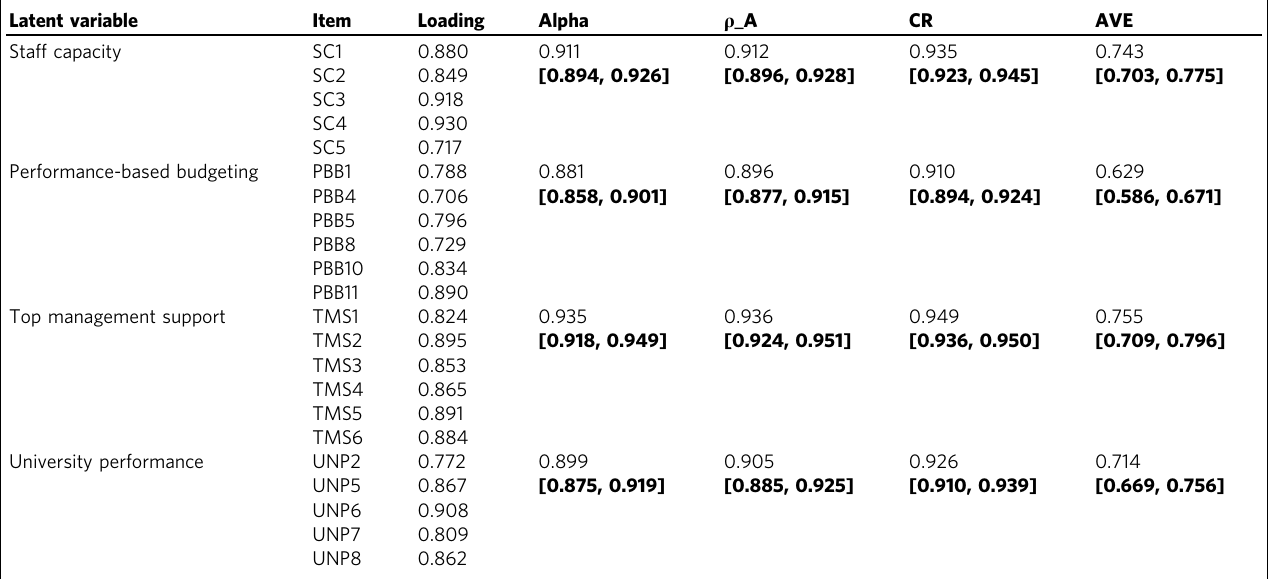
Table 2 Loadings, convergent validity, and reliability estimates.